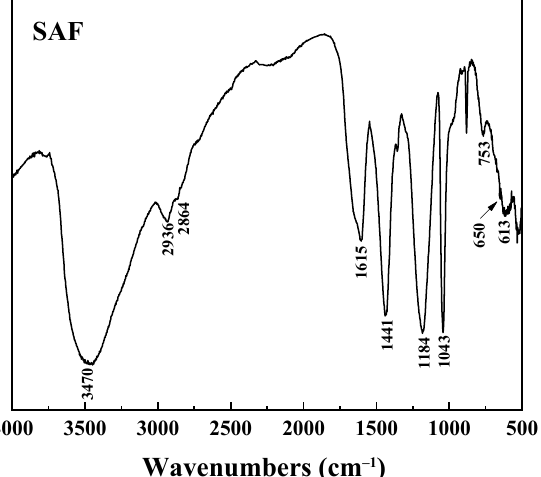
Figure 3. FTIR spectra of the sulfonated acetone formaldehyde condensate